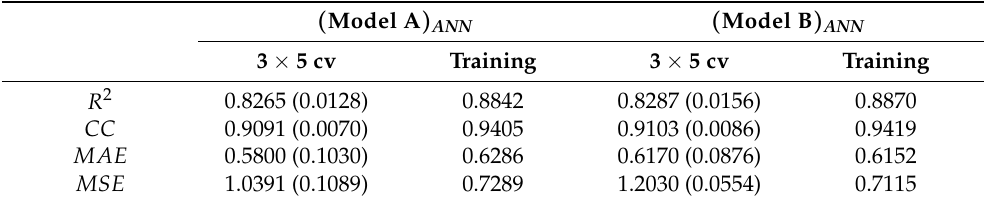
Table 3. Artificial Neural Network results. Values (mean and standard deviation) of the different measures when using a 3 × 5-fold cross-validation and when using the whole dataset as training are shown.